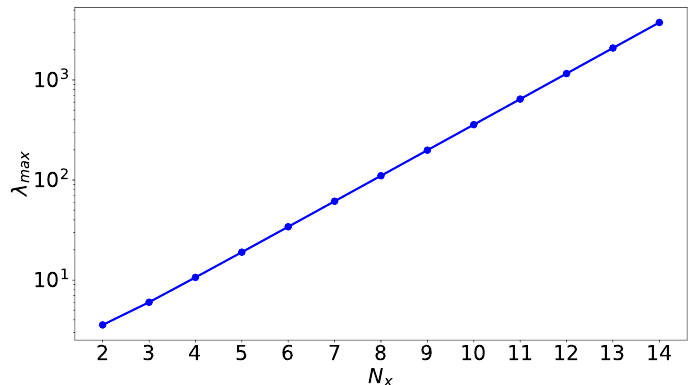
Figure 5: Scaling of the largest eigenvalue λ on the lattice size in x -direction N